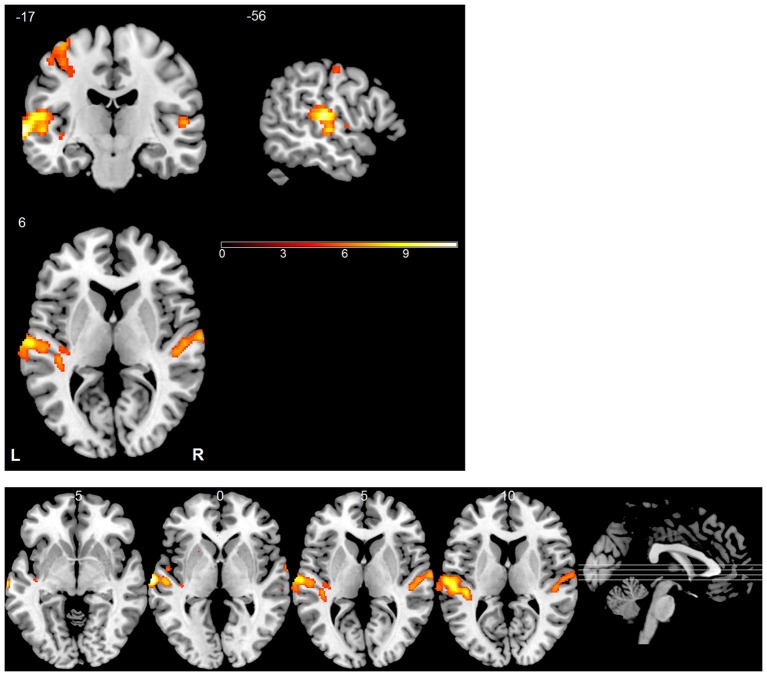
Statistical parametric map of active regions using “stimulus vs. silent” contrast. The significance level for activation was set at p < 0.05 (FDR corrected). The bottom panel shows a multi-slice orthogonal view.